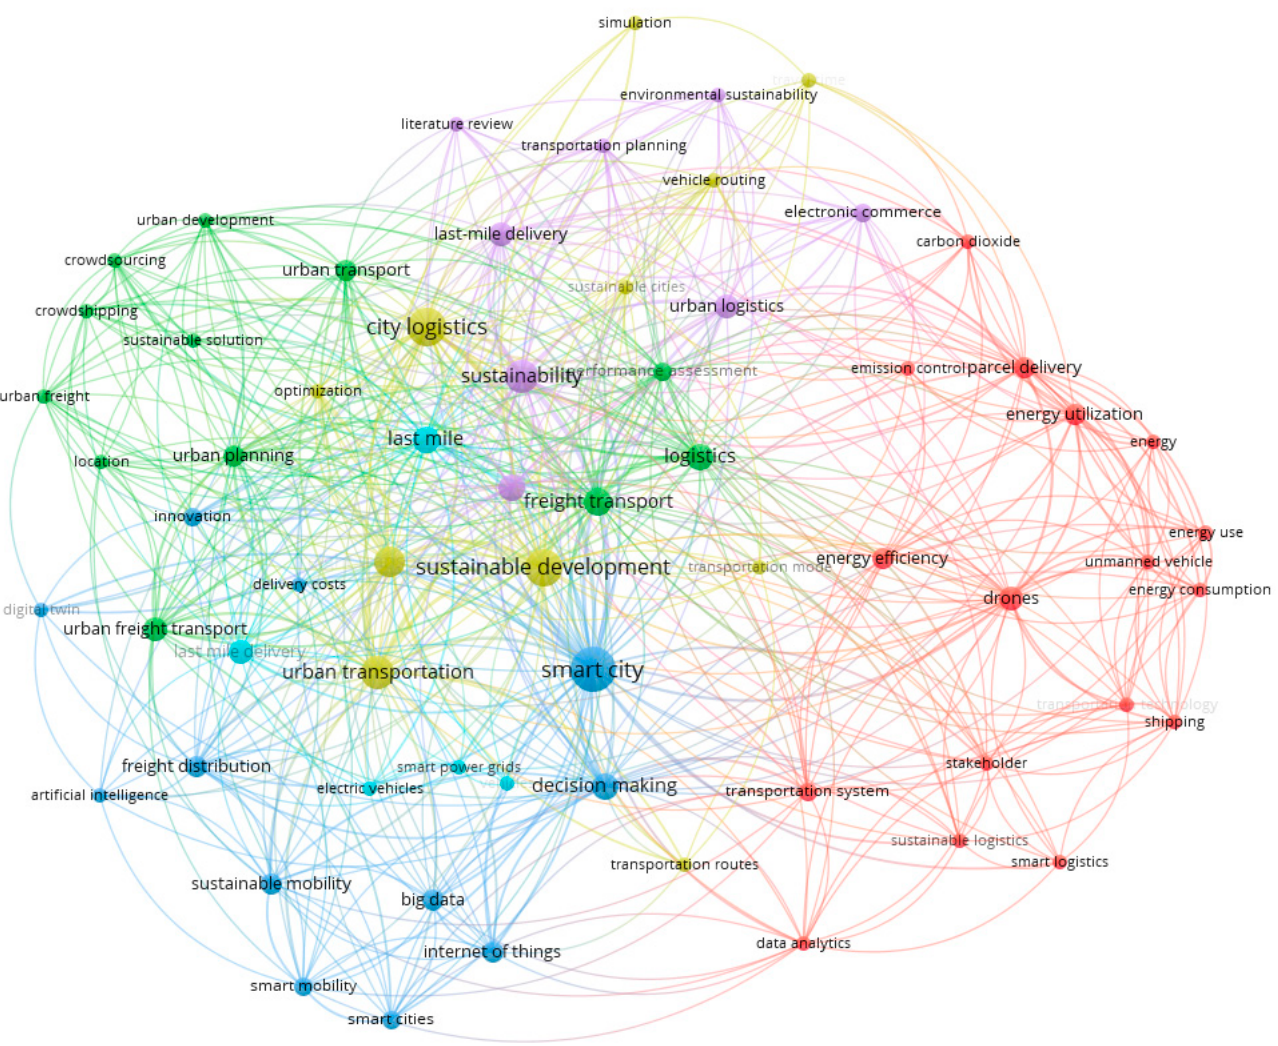
Figure 9. Most-occurring keywords (at least 2 times) and the co-occurrence among the identified publications.